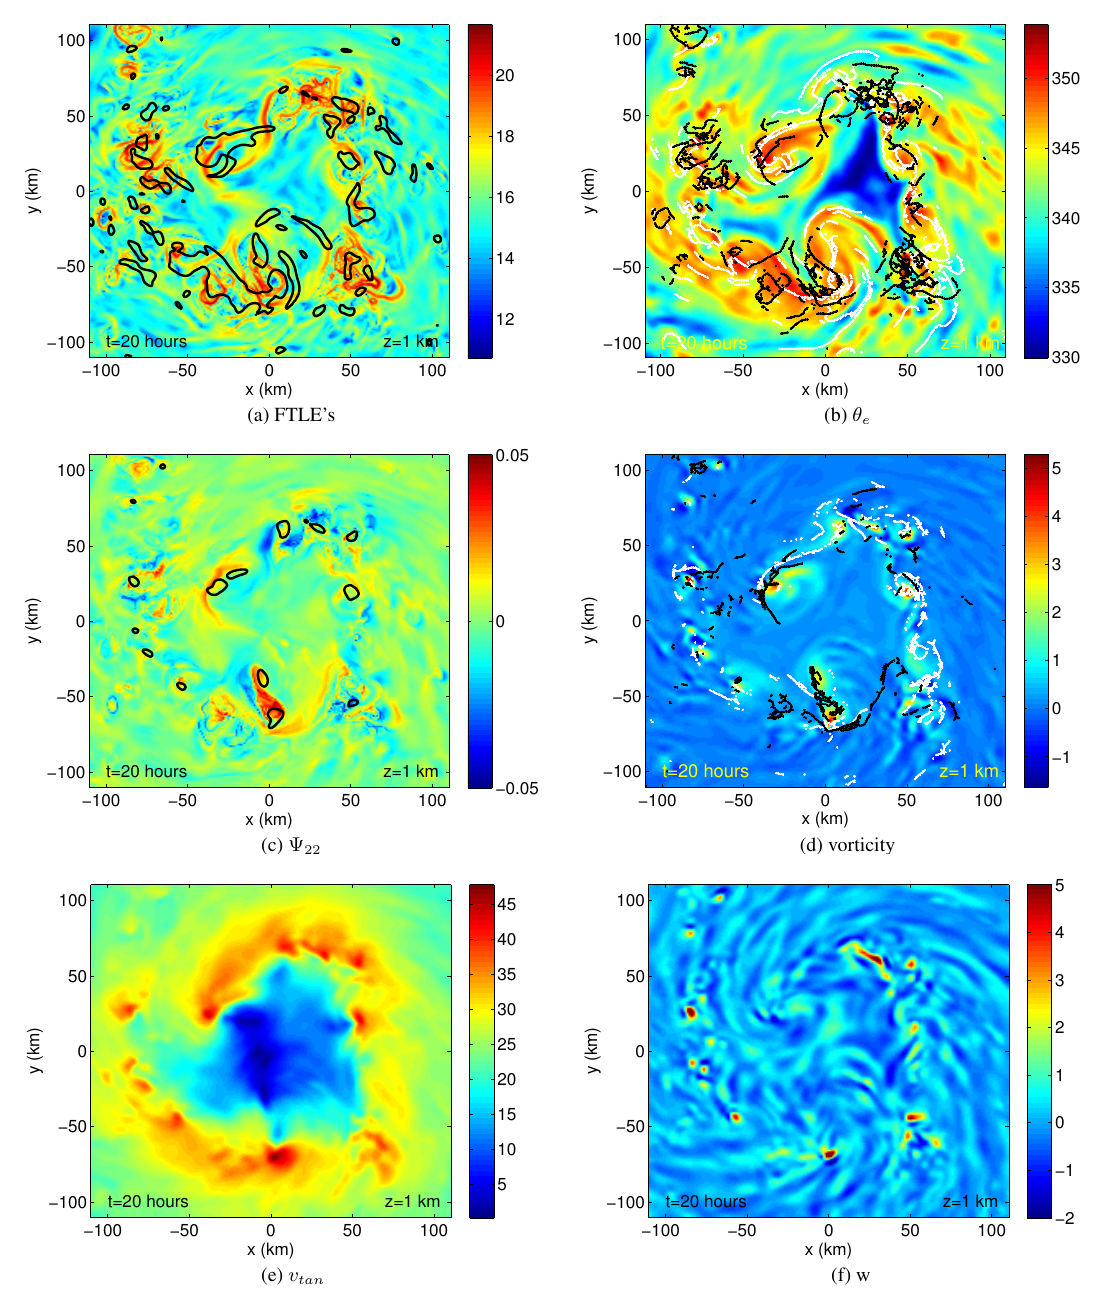
Fig. 8. Horizontal slices of Lagrangian fields and Eulerian diagnostics are compared at 20 hours and 1 km height. The FTLE field (a) has ridges, which are extracted and overlaid on the θ e field (b). The Ψ 22 field (c) has ridges, which are extracted and overlaid on the ζ field (d). Tangential winds and vertical velocity are shown in (e) and (f).